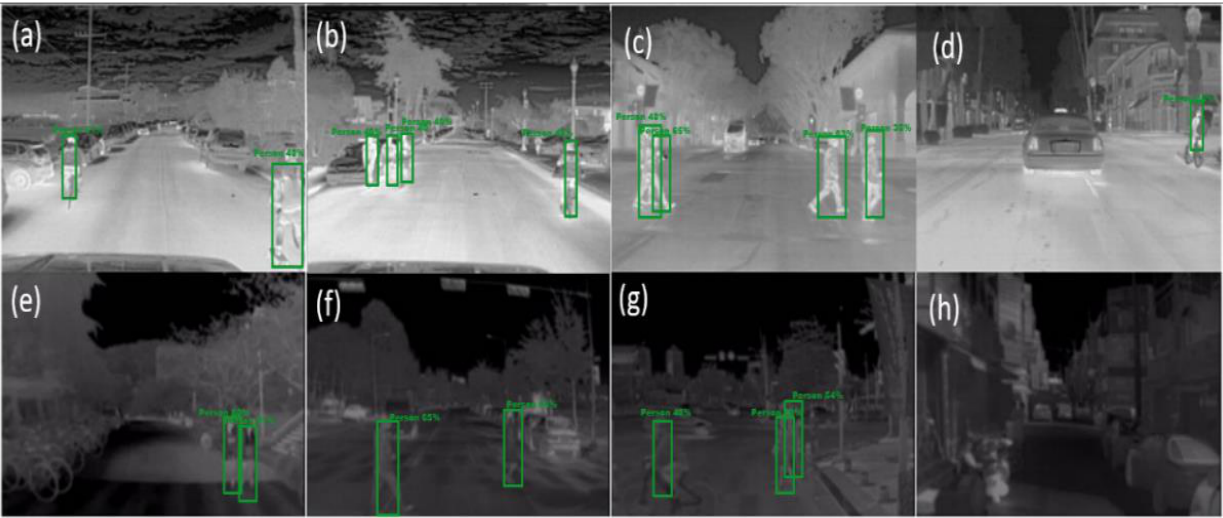
Figure 15. Qualitative results of human recognition (small object) on thermal images under different walking conditions, using our YOLOv3-Human model. Row 1: FLIR ADAS dataset. Row 2: KAIST dataset.